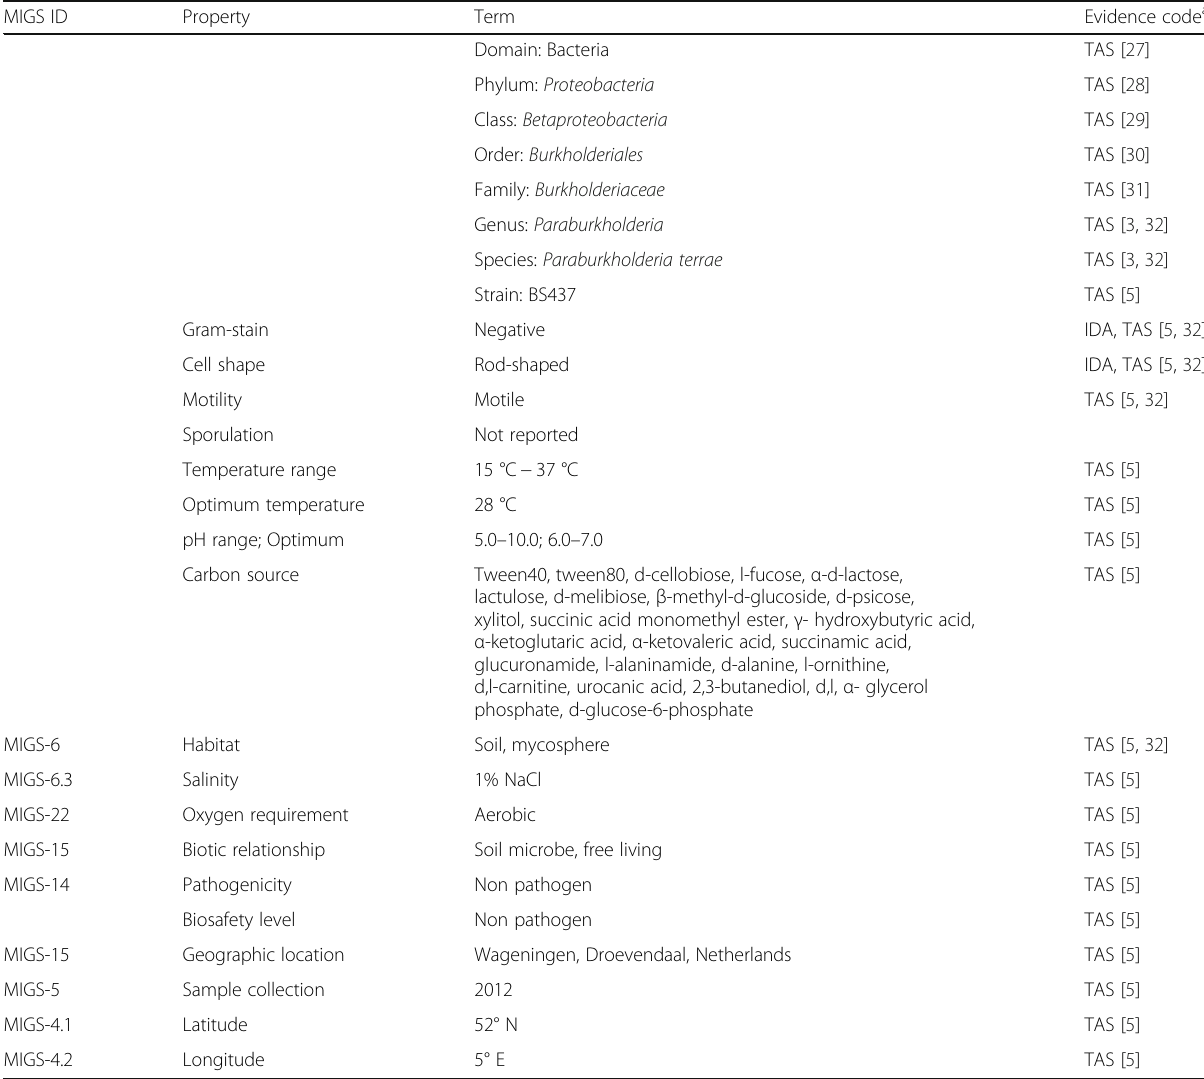
Table 3 Classification and general features of Paraburkholderia terrae strain BS437